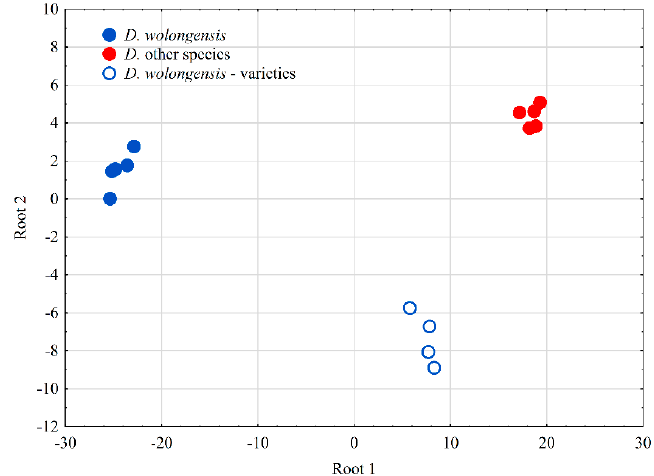
Figure 2. A scatterplot of canonical scores of the three groups of Daphne s pp.